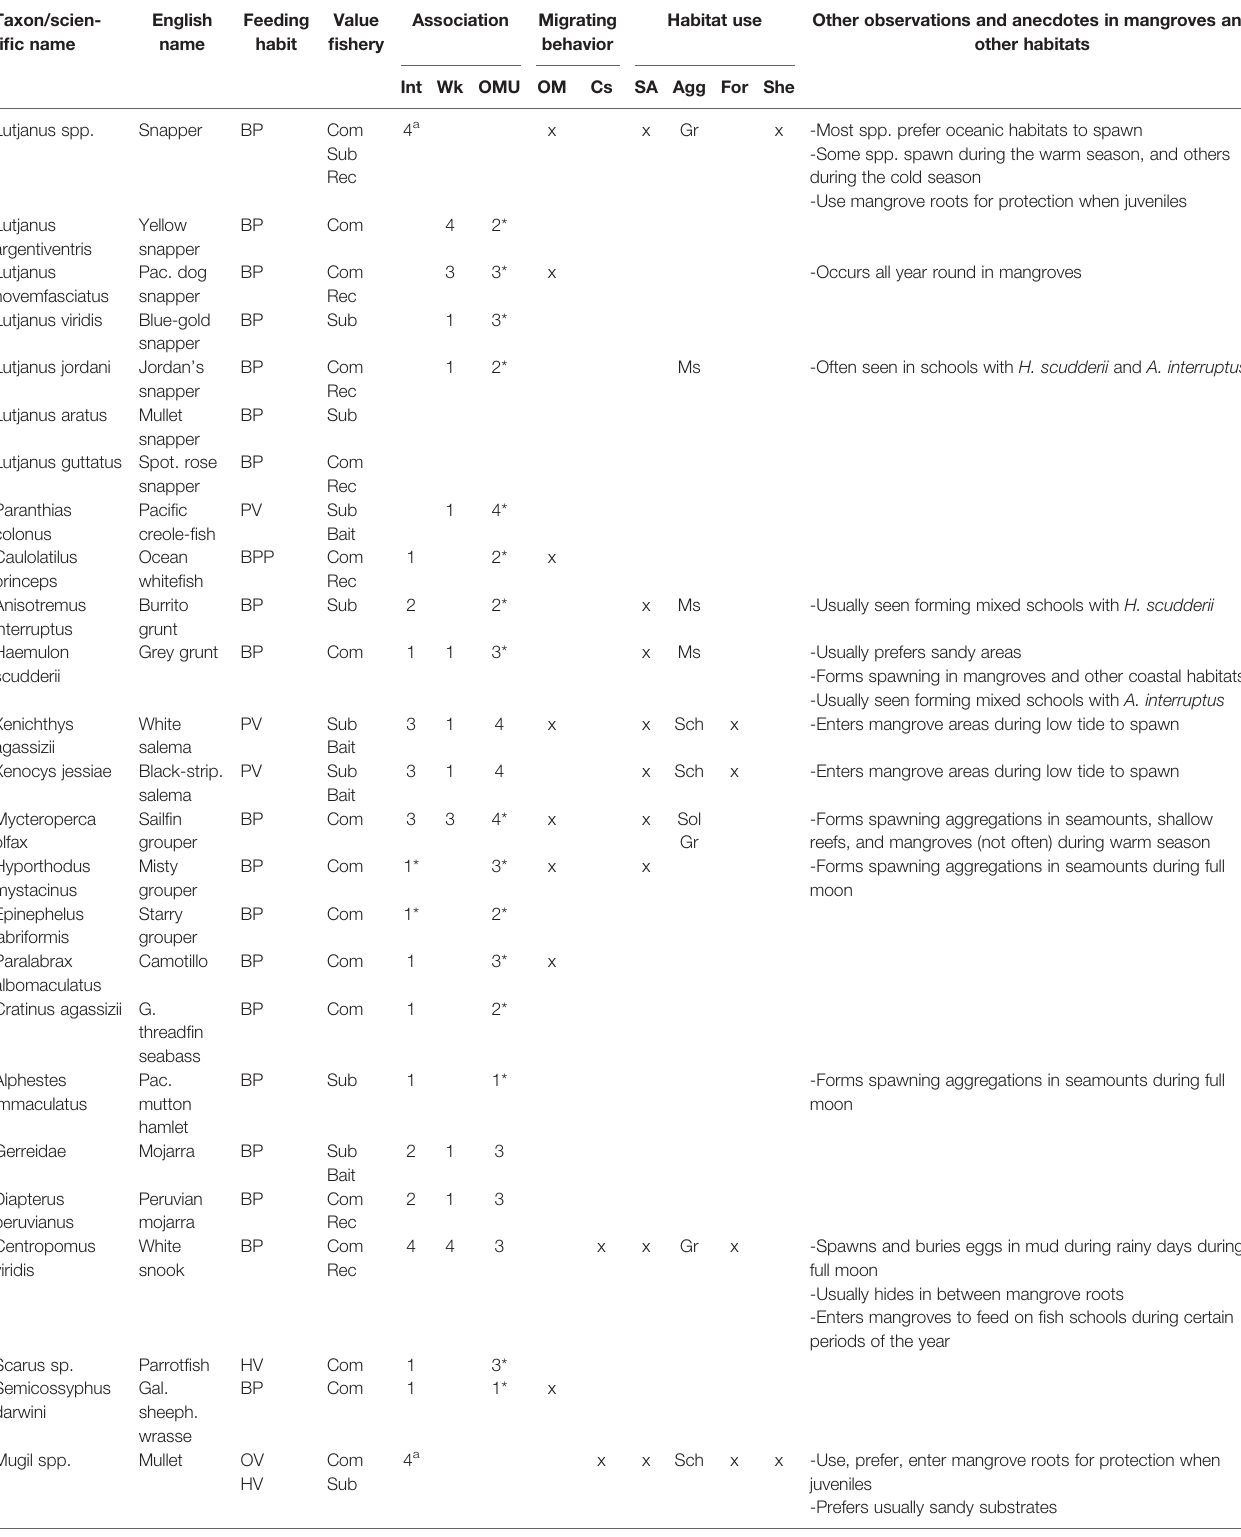
TABLE 1 | Summary of fi shery species (or taxa) associated to mangroves by Galapagos fi shers during interviews (Int; N = 35), and by groups of fi shers during community workshops (Wk; N = 5)- , and by other mangrove users (i.e., naturalist guides, park rangers, scientists; OMU; N = 33). Taxon/scien- ti fi c